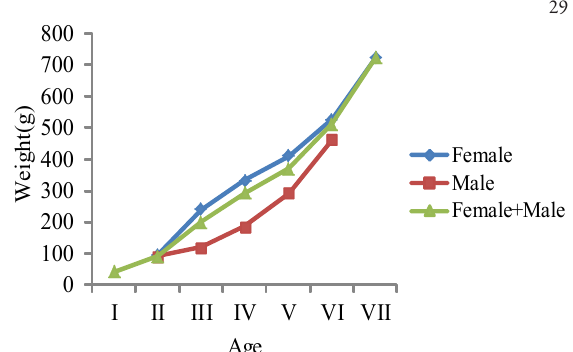
Fig. 4. The age-weight relations for S. cephalus in Orenler dam